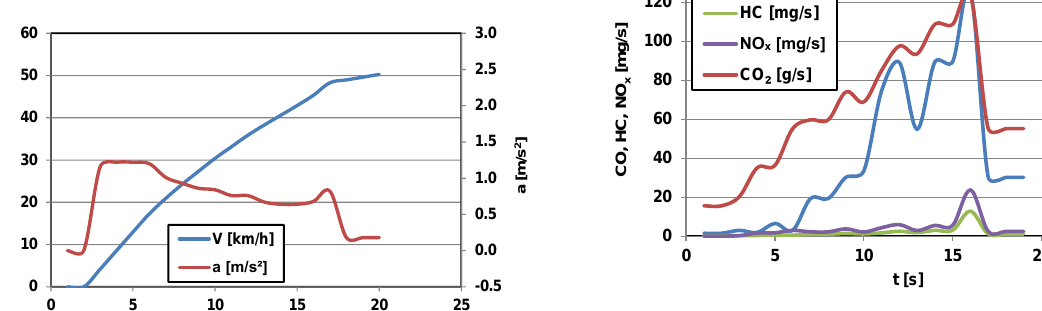
Fig. 9. Emission rates of individual exhaust gas components as a function of simulation time for: a = 1.0 m/s